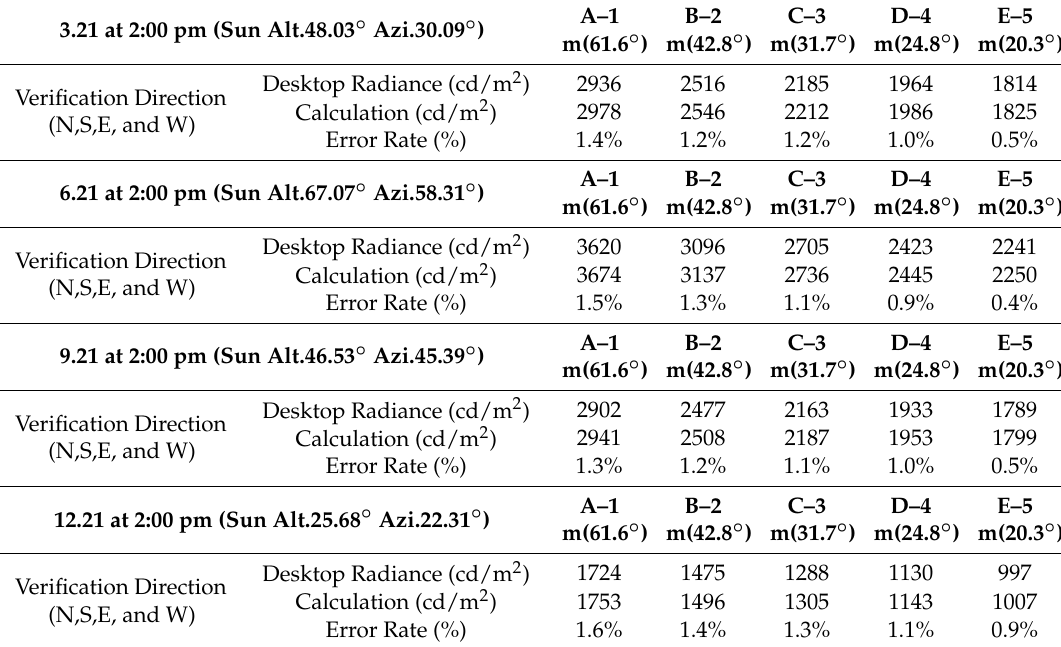
Table 10. Prediction results and error rate of sky luminance distributions in CIE overcast